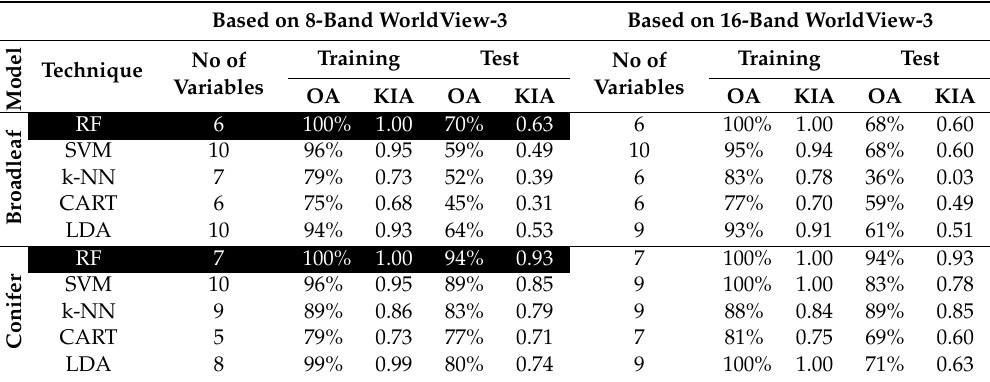
Table 6. Summary of the performance assessment using training and test sets for the five modelling techniques (RF, SVM, k-NN, CART and LDA) for broadleaf and conifer species modeling. For tree mapping, the selected modeling techniques with the highest overall accuracy (OA) for each model are highlighted in dark. KIA: Kappa Index of